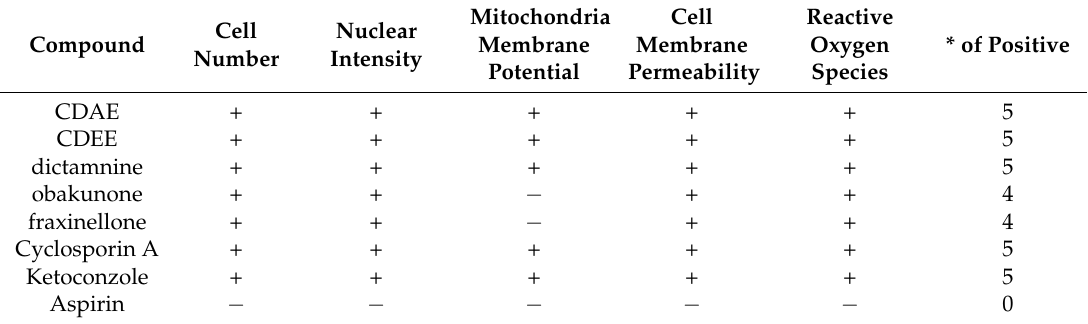
Table 6. Cytotoxicity of test compounds and the control compound in HepG2 cells using high-content analysis